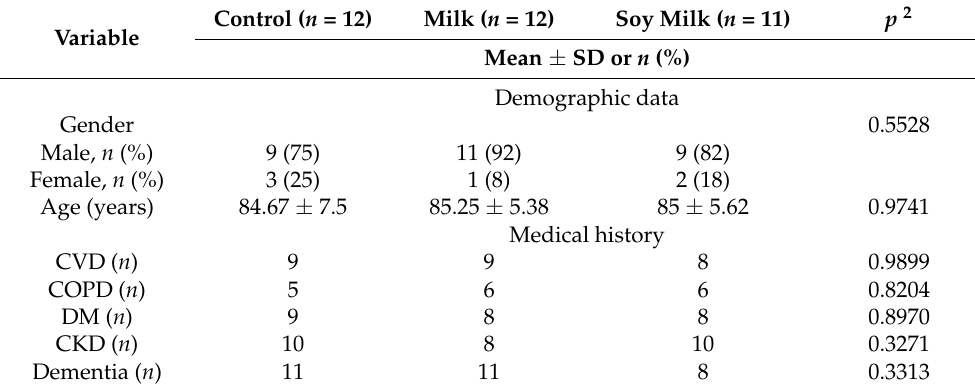
Table 1. Basic characteristics of sarcopenic subjects 1 .